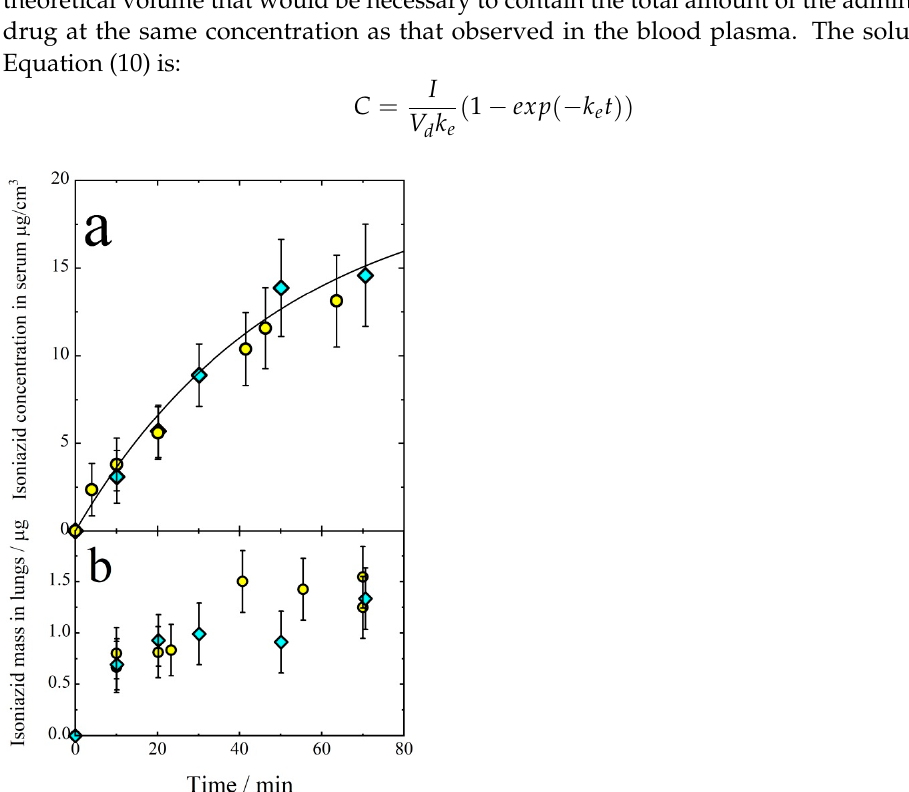
Figure 2. Isoniazid concentration in the blood serum ( a ) and its mass in lungs ( b ) as a function of inhalation time. Diamonds and circles refer to the expositions in WB and NO inhalation chambers, respectively. Solid line follows Equation (11). The rate of aerosol delivery is I = 10 μ g/min .